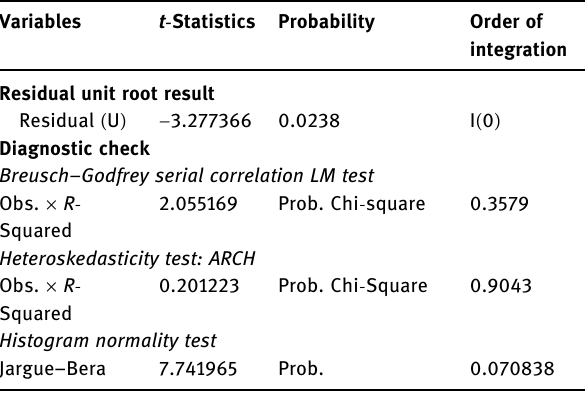
Table 3: Residual unit root result and diagnostic